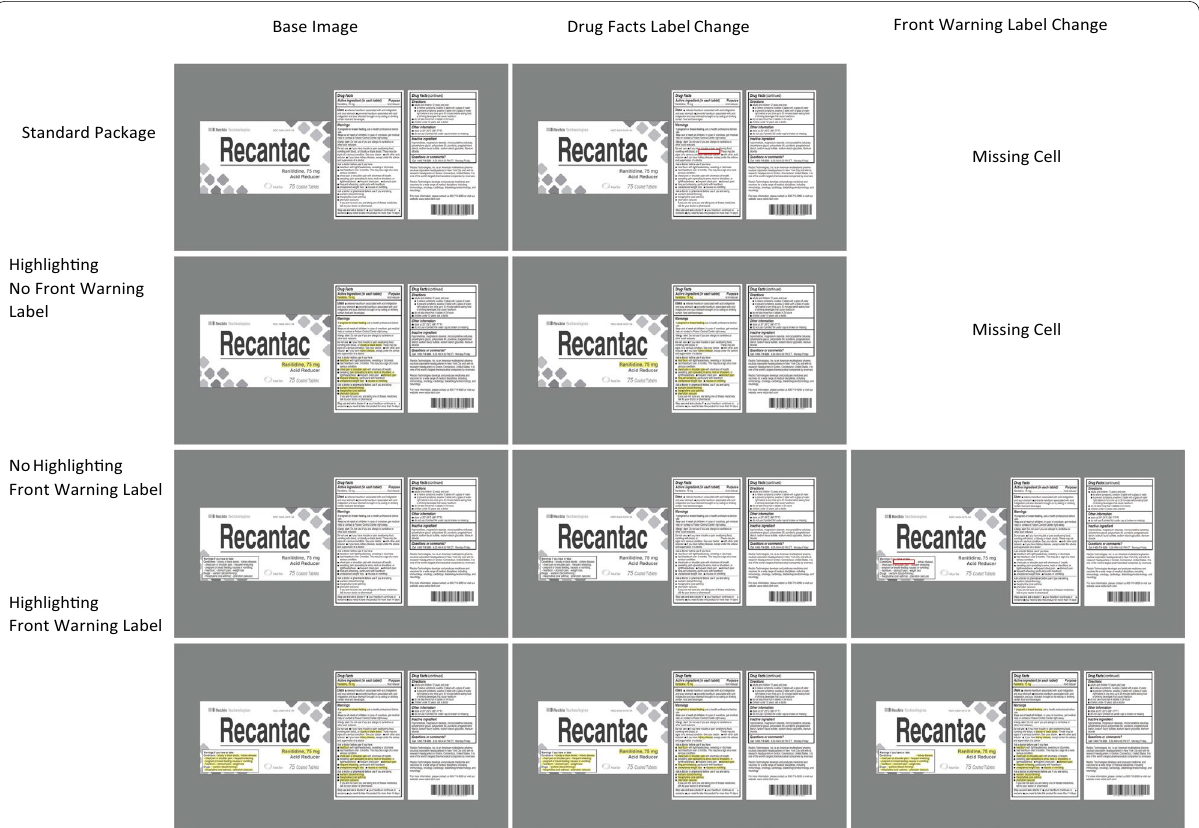
Fig. 4 Examples of the six warning changes for a given brand. The left column depicts the complete label for the 4 label treatments. The middle depicts the altered images with a change to the Drug Facts Label. The right depicts the altered images with a change to the front warning label. The red squares in the top row are to illustrate the change location and did not appear in the